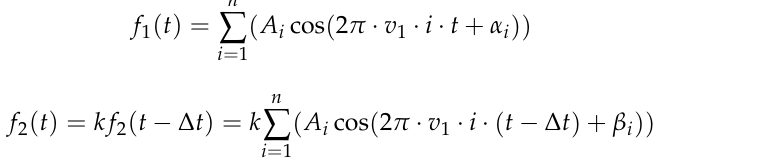
Figure 6. Graph of phase spectrum difference from two sensors.